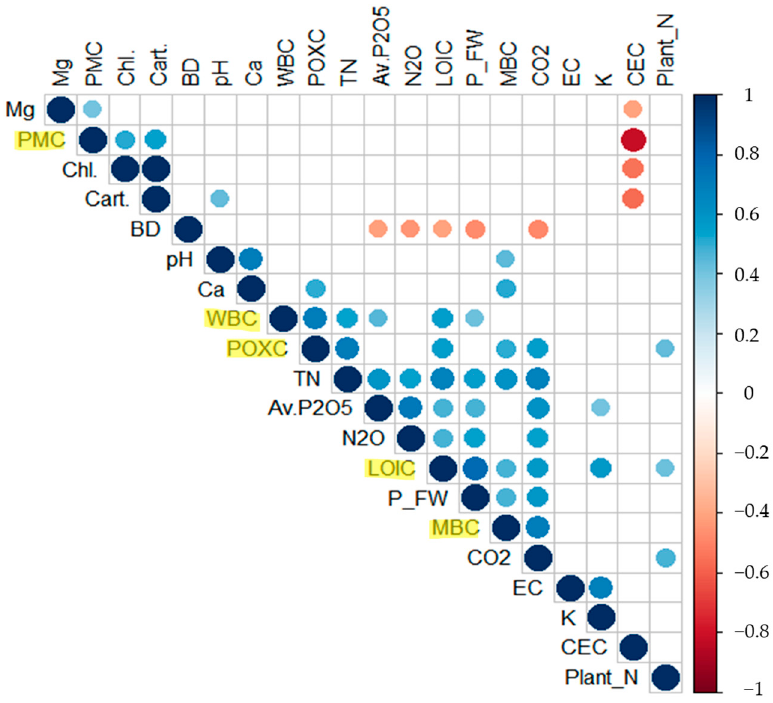
Figure 3. Correlation matrix among soil organic C fractions (LOIC, WBC, POXC, PMC, and MBC; highlighted in yellow), soil biogeochemical parameters (bulk density, pH, EC, CEC, soluble P, K, Mg, and Ca), plant physiological parameters (FW, N content, and total chlorophyll and carotenoid content). The areas of circles show the value of corresponding Pearson correlation coefficients with significance at the 0.05 probability level. Correlation values are indicated by circle in the upper panel; positive correlations are displayed in blue and negative correlations in red. Color intensity (light to dark) and the size of the circle (small to big) are proportional to the correlation coefficients (0 to 1 for the positive coefficient and 0 to − 1 for negative coefficient) where, for example, the correlation coefficients on the principal diagonal are equal to 1 (it was represented in dark blue and biggest size of circle). The legend on the right side of the correlogram shows Pearson’s correlation coefficients with their corresponding colors.